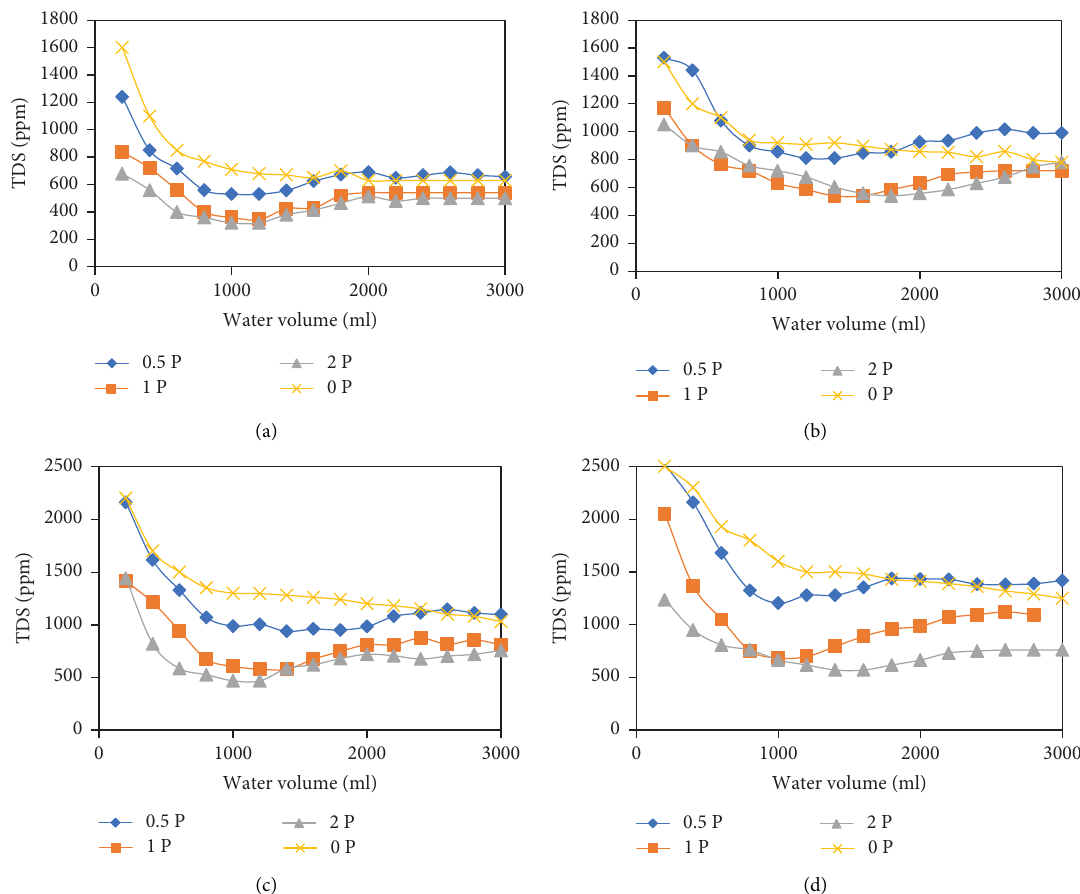
Figure 7: TDS-leachate water change of pectin-treated soil samples (a) soil 1, (b) soil 2, (c) soil 3, and (d) soil 4.